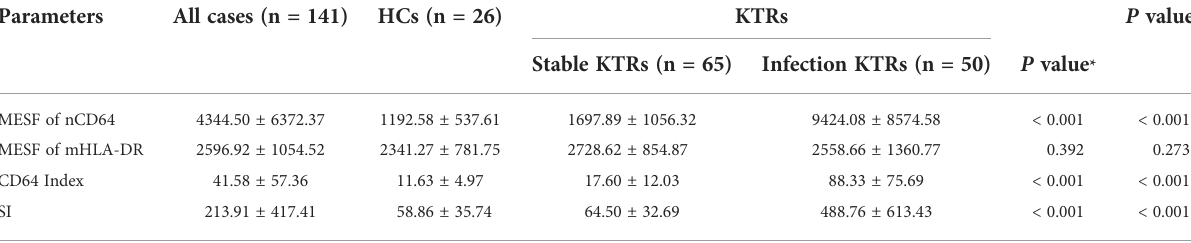
*Comparison between the stable KTRs and the infection KTRs. # Comparison among the three groups. Tested by the least signi fi cant difference test for back testing of multivariate ANOVA. HCs, Healthy controls; KTRs, kidney transplantrecipients, nCD64, neutrophil CD64; mHLA-DR, monocyte HLA-DR; MESF, molecules of equivalent soluble fl uorochrome; SI,sepsis index.